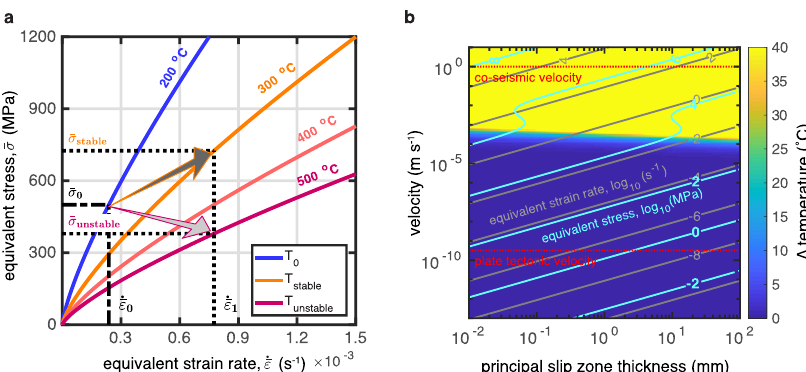
Fig. 5 Rheology of nanocrystalline fault rocks and implications for earthquake instability. a Schematic diagram of equivalent stress as a function of equivalent strain rate, as predicted by the experimental fl ow law. Shear heating can result in “ rate weakening ” behavior if T increase compensates (cid:2) σ increase (arrows). b Equivalent strain rate and equivalent stress at 300 °C for a range of strain rate values plausible for natural fault zones. Note that the nanocrystalline fault rocks fl ow at 10 − 4 s − 1 at ≈ 100 MPa stress and at 10 − 6 s − 1 at units of MPa, i.e., are extremely weak for the base of the seismogenic